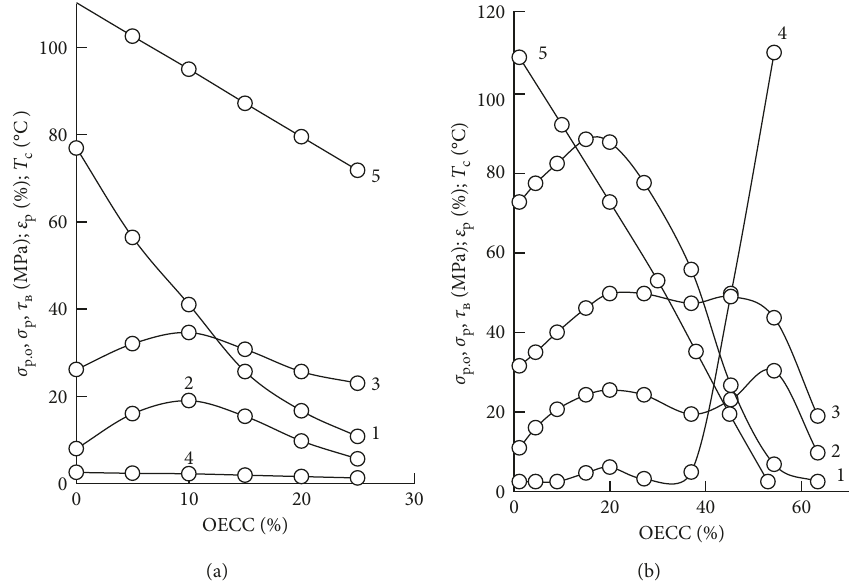
Figure 7: Dependence of the epoxyurethane polymer properties on the basis of ED-20 +DCC/ED-20+DETA (a) and ED-20 +DCC/DEG- 1+DETA (b) on the OECC modifying concentration, σ p (1), τ c (2), σ r .o (3), E r (4), and T s (5).